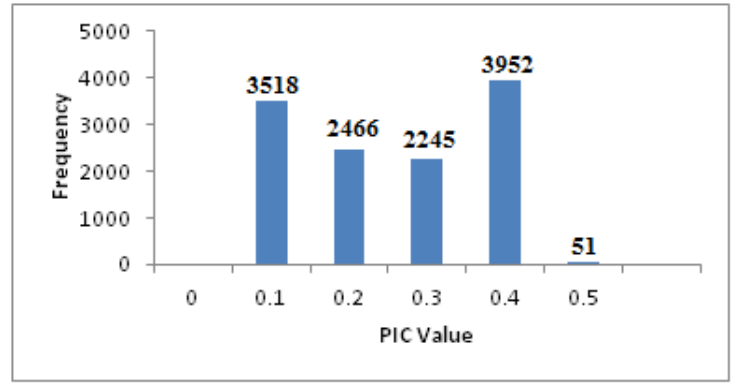
Figure 3. Frequency distribution of PIC values of 12232 silicoDArT markers.